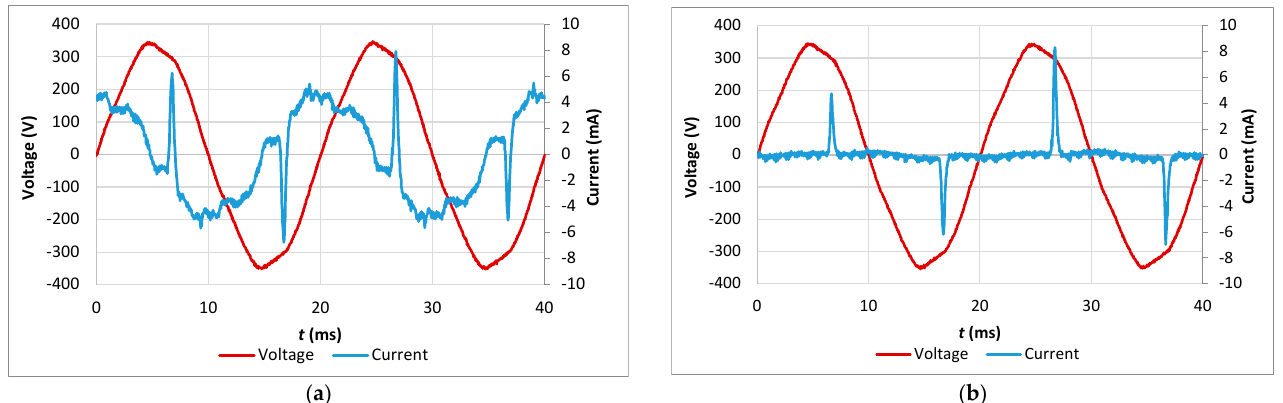
Figure 6. Power consumption of AC/DC adapters for the no-load condition: ( a ) 230 V to 3.3 V converter; ( b ) 230 V to 5 V converter.